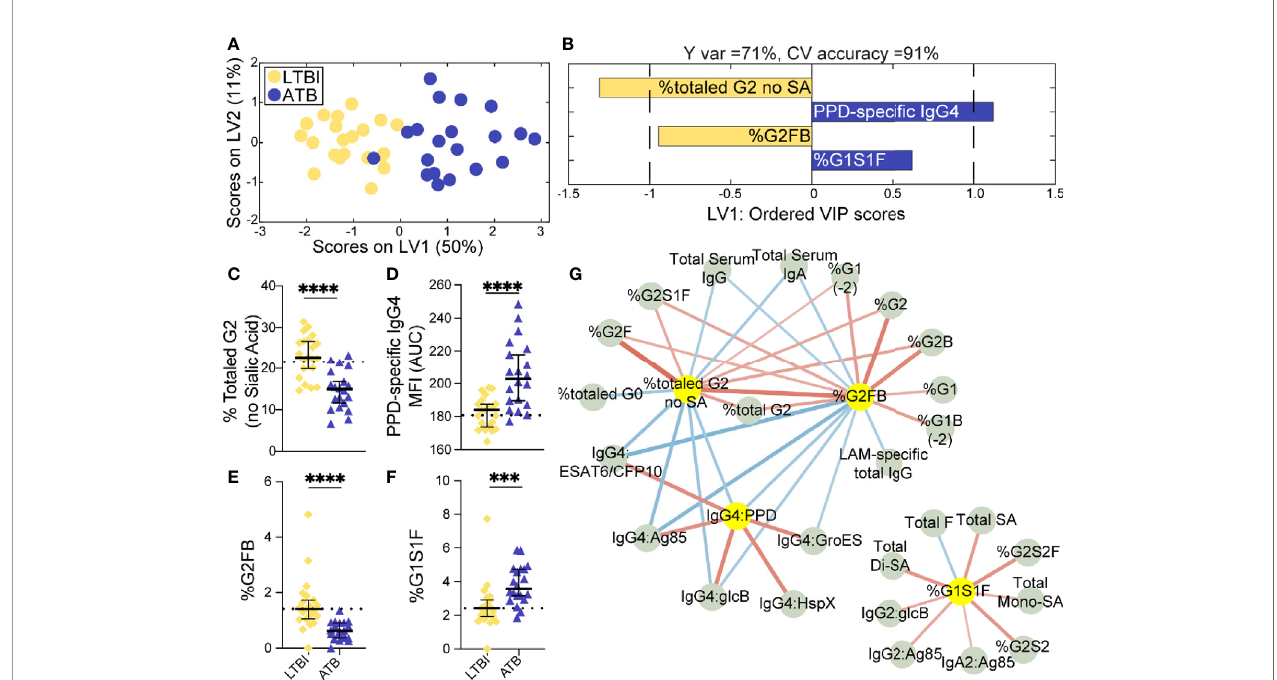
FIGURE 1 | Fc-glycosylation and TB-speci fi c IgG subclass distinguish LTBI and ATB individuals. An orthogonalized PLSDA ( OPLSDA) model was created based on four LASSO-identi fi ed antibody features that discriminate LTBI from ATB (A, B) . Latent variable 1 (LV1) explains 71% of Y variance in the direction of LTBI and ATB separation. 5-fold cross validation (CV) was performed, resulting in 91% CV accuracy. The model signi fi cantly outperformed models based on shuf fl ed group labels (permutation testing, Wilcoxon p=2E-5) (A) PLSDA scores plot depicts model separation of LTBI (n = 21, yellow dots) and ATB (n = 20, blue dots). LV1 and LV2 account for 50% and 11% of the variability of the input features. (B) Variable Importance in Projection (VIP) scores plot of top features providing the greatest resolution of LTBI and ATB in rank-order. Directions of the bars signify loadings on LV1 and colors represent the disease groups in which measures were enriched. Pairwise comparison of LTBI (n = 21, yellow diamonds) and ATB (n = 20, blue triangles) individuals (C) The frequencies of totaled G2 structures without sialic acid on IgG-Fc of LTBI and ATB individuals. (D) AUC of PPD-speci fi c IgG4 titers. (E) percentage of G2FB glycan on IgG (F) percentage of G1S1F glycan on IgG. Univariate plots (C-F) show median and interquartile range of each LASSO-selected measure; statistically signi fi cant differences between LTBI and ATB groups calculated using Mann-Whitney test: ***p < 0.0005 and ****p < 0.0001. The dotted lines represent median of healthy controls individuals tested. (G) Correlation analysis depicts other features that are positively (red lines) or negatively (blue lines) correlated with these four key features selected with LASSO (highlighted in yellow). The color intensity and width of the edges between nodes are proportional to the signi fi cance of correlation coef fi cients after correcting for multiple comparisons (Benjamini-Hochberg q-value < 0.05, testing the hypothesis of zero correlation). Only correlations with corrected p-values < 0.05 were